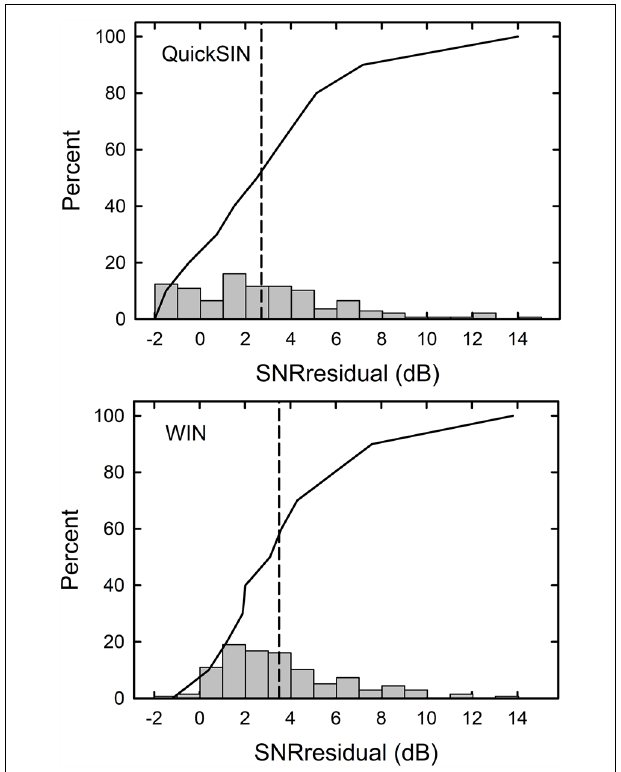
FIGURE 7 | Histograms (gray vertical bars) and cumulative distributions of the SNRresidual values for the QuickSIN (top) and WIN (bottom) for the 137 older adults in this